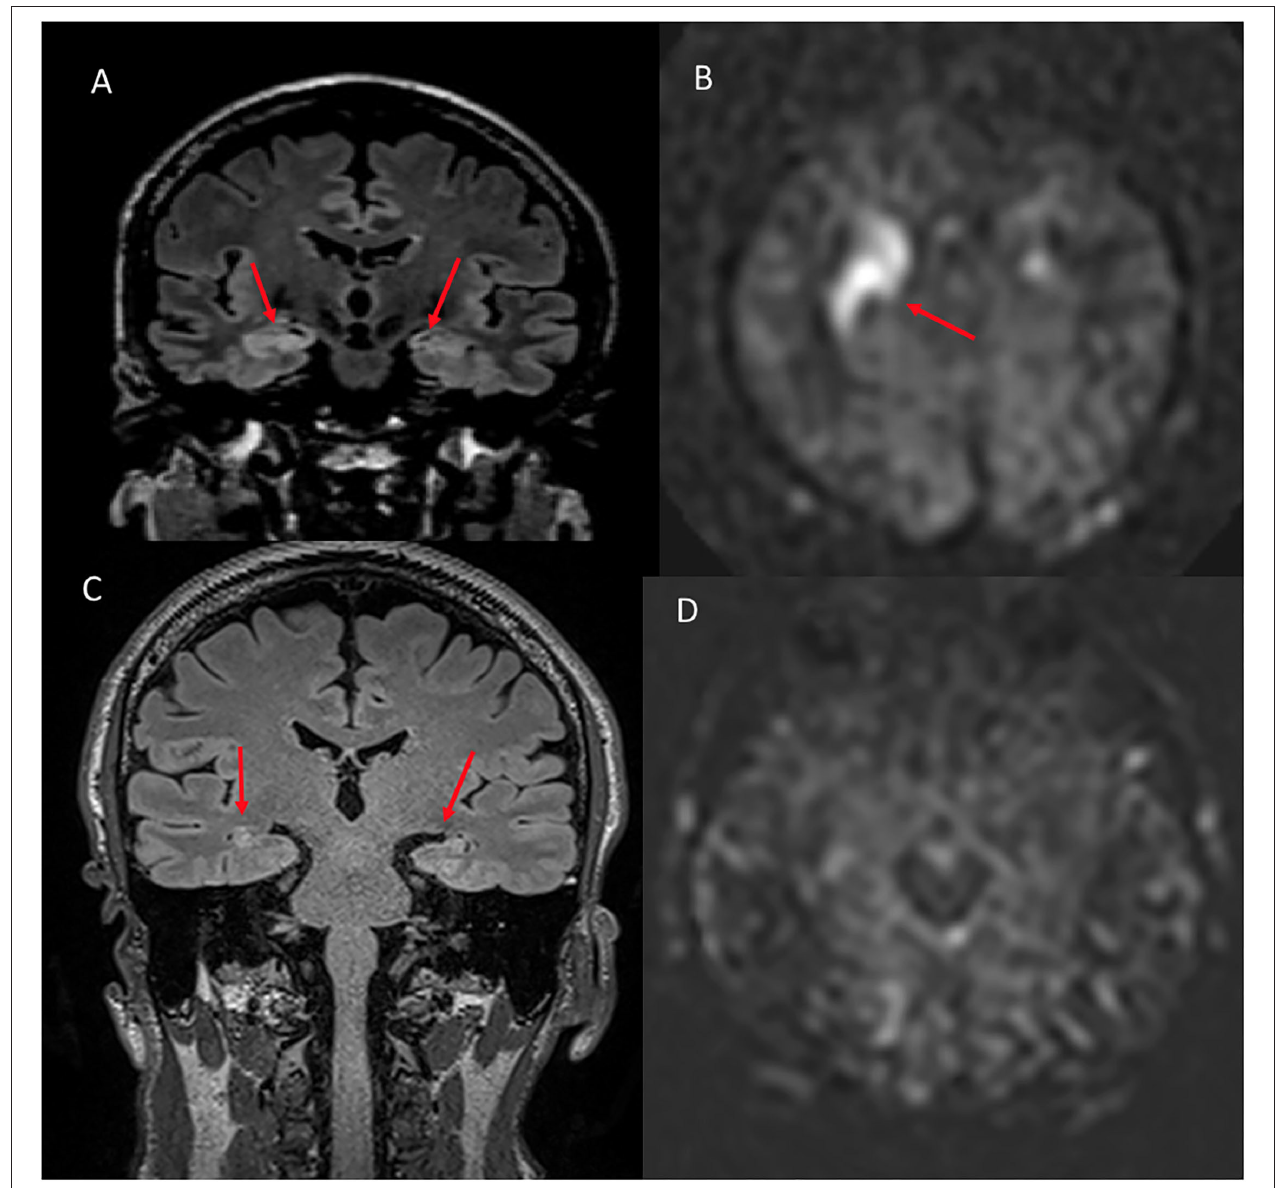
FIGURE 6 | A 48 year old male with memory loss and seizures. (A) Coronal FLAIR shows hyperintense signal in the right greater than left hippocampus and amygdala. (B) ASL shows hyperperfusion in the corresponding regions. (C) Six month follow up coronal FLAIR shows hyperintense signal in the bilateral hippocampi compatible with mesial temporal sclerosis. (D) Six month follow up ASL demonstrates complete resolution of the previously seen